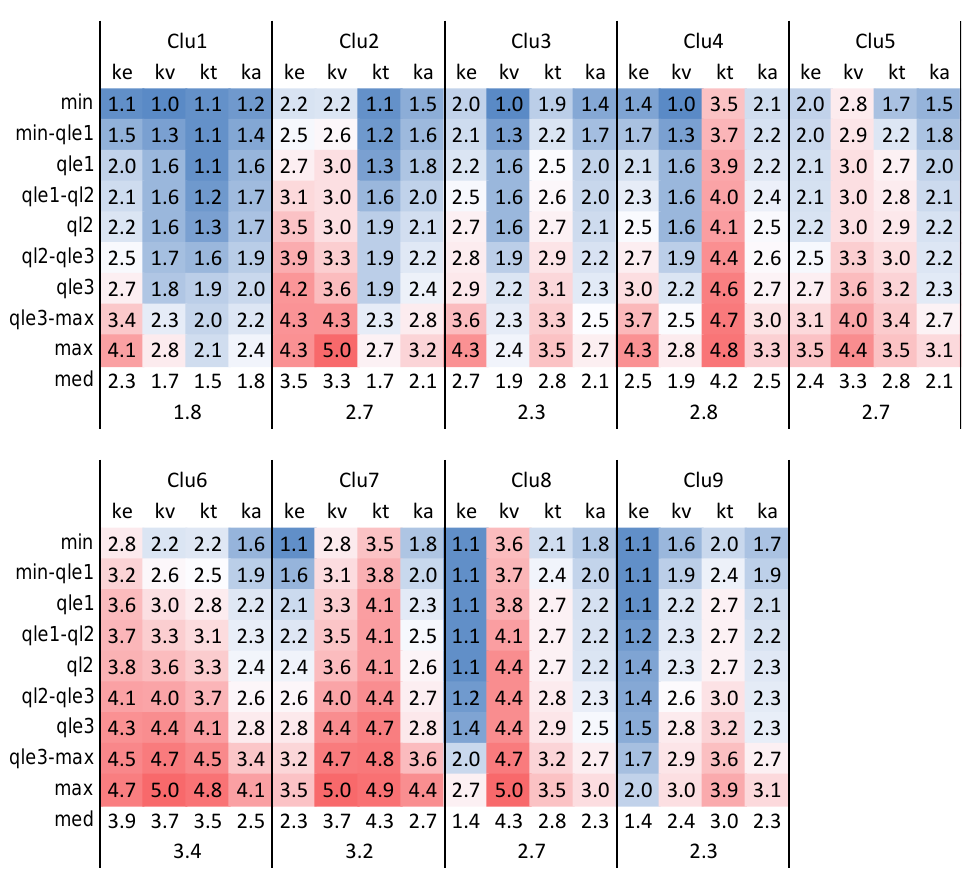
Figure 9. Comparison of the different clusters by minimum, average, maximum, and quartiles (normalised) scores of the main characteristics.